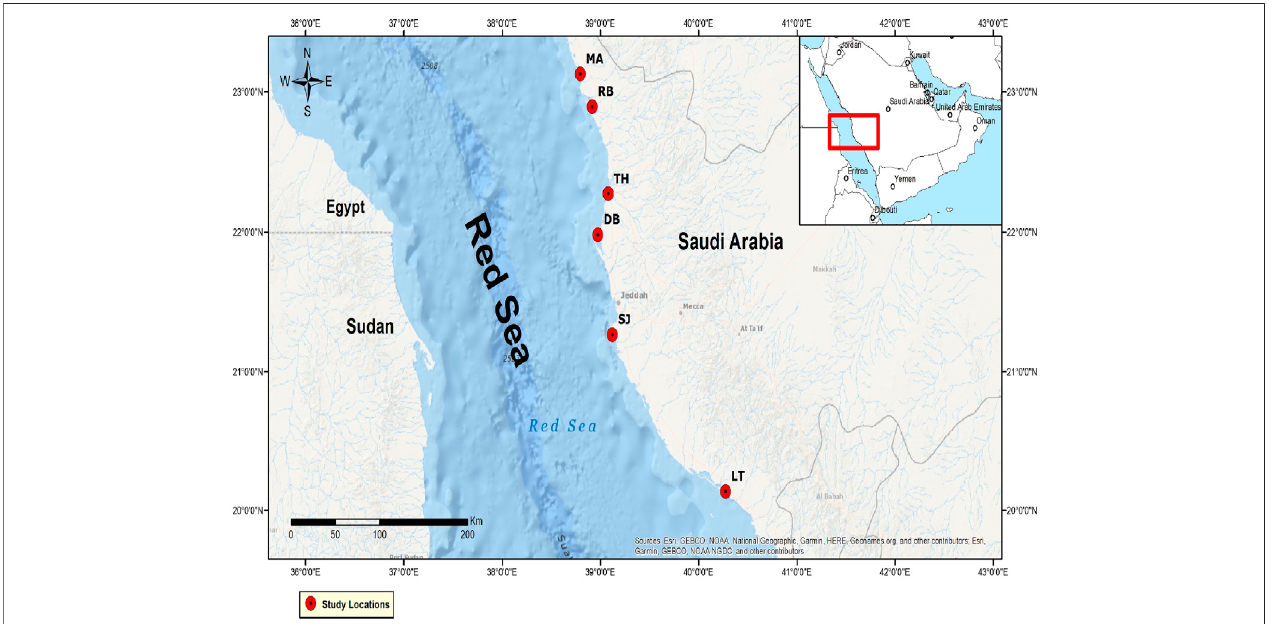
FIGURE 1 | Map showing six mangrove ecosystems in central Red Sea, Saudi Arabia. LT: Al Lith; SJ: south Jeddah; DB: Dahban; TH: Thuwal; RB: Rabigh; MA: